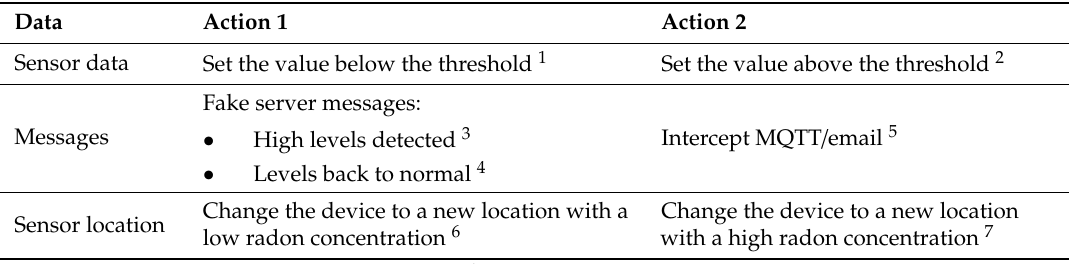
Table 2. Data tampering